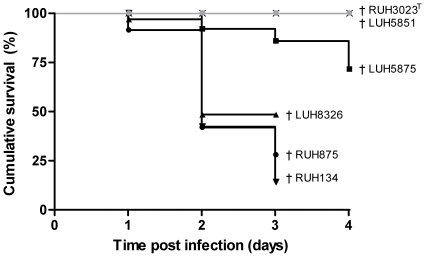
Survival associated with Acinetobacter respiratory infection.Survival of mice after intratracheal infection with A. baumannii clone I strain RUH875, clone II strain RUH134, clone III strain LUH5875, sporadic strain LUH8326 and type strain RUH3023T, and A. junii strain LUH5851. Results are expressed as percentage survival at days 1–4 of infection. †, all mice dead/sacrificed.